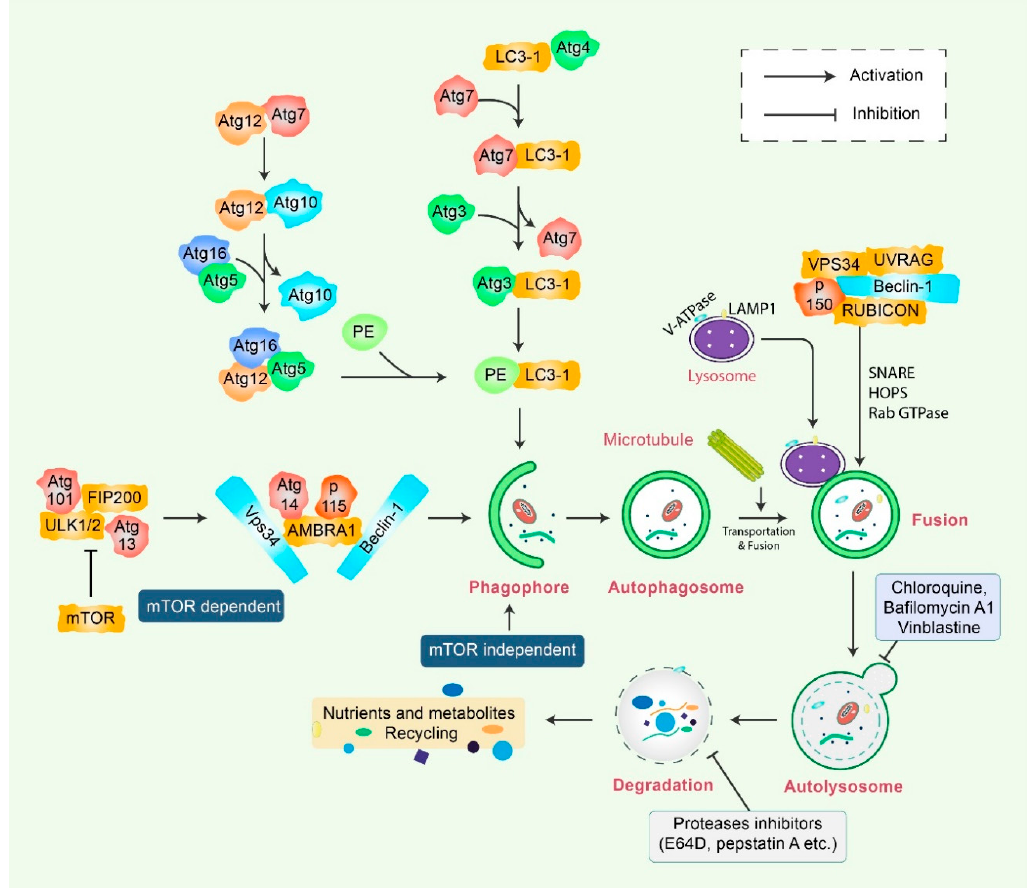
Figure 1. Molecular mechanism of autophagy signaling. Autophagy is generally initiated by a deficiency of growth factors or nutrients that trigger AMPK or mTOR inhibition. This stimulates FIP200 and Atg13 associated ULK complex. After that phosphorylation of Beclin-1, it leads to the activation of VPS34, which further initiates the formation of phagophore. Conjugation of Atg5-Atg12 encompasses Atg7 as well as Atg10 to form an Atg12-Atg5-Atg16 complex that also stimulates phagophores formation. Atg5, in addition to Atg12, makes an Atg16 complex, which acts as an E3- function concerning LC3-PE assembly (LC3-II). This complex likewise initiates the formation of a phagophore. Specifically, LC3-II is an autophagy marker that is ultimately interrupted via autolysosomes. Maturation of autophagosome leads to fusion with lysosomes in association with several lysosomal proteins, finally leading to degradation of cargo in addition to recycling of metabolites and nutrients.